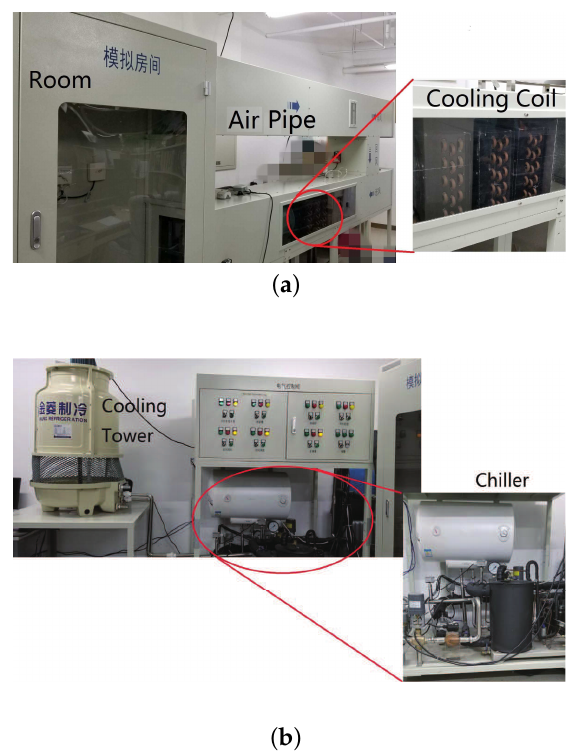
Figure 5. The major components of an experimental HVAC system: ( a ) the cooling coil and room, ( b ) the chiller and cooling tower.